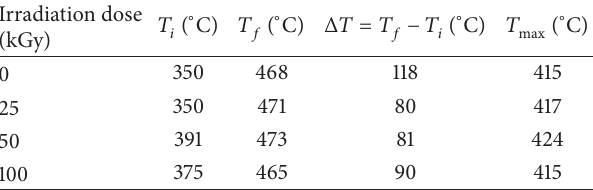
Table 3: Thermal properties of 50 wt% nHA/PA66 composites from TG and DTG